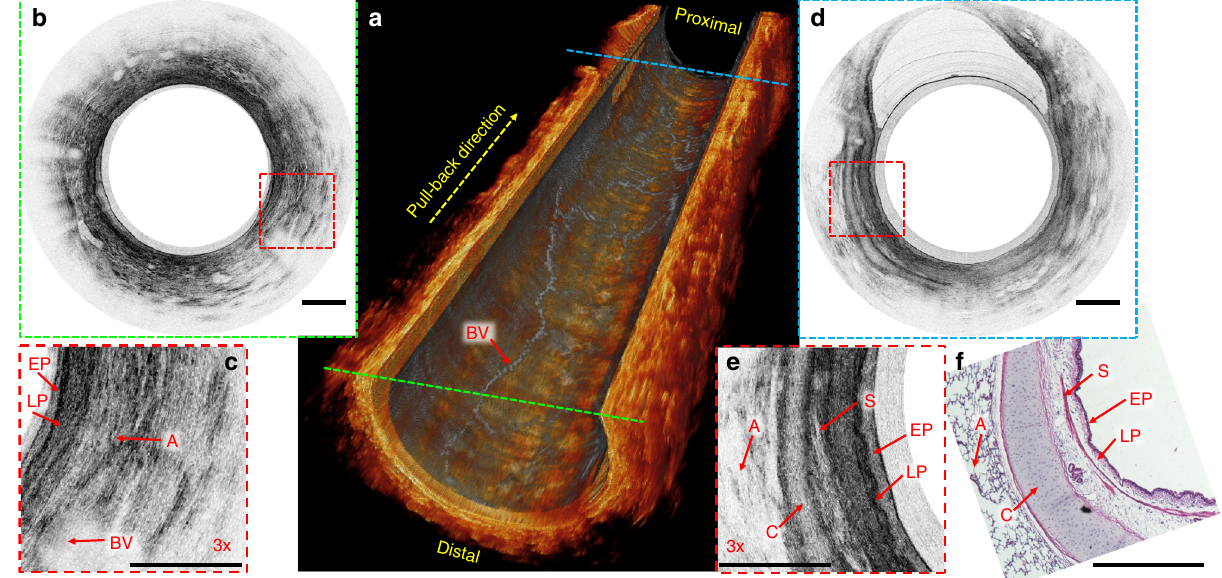
Fig. 7 In vivo endobronchial imaging of sheep small airways. a Cut-away view of a reconstructed three-dimensional (3D) image of an 8 mm-long sheep small airway with the en face projection view of blood vessels overlaid on the inner surface of the three-dimensional (3D) image. b Representative in vivo 2D image of the peripheral sheep airway corresponding to the cross-section indicated with the green dashed line in ( a ). c 3x enlarged view of the area boxed with red dashed lines in ( b ). d Representative in vivo 2D image of the sheep small airway, which is relatively more towards the proximal side (indicated with the blue dashed line in a ). e 3x enlarged view of the area boxed with red dashed line in ( d ). f Corresponding haemotoxylin and eosin (H&E) histology. A alveoli, BV blood vessel, C cartilage, EP epithelium, LP lamina propria, S smooth muscle. All scale bars are 250 µ m